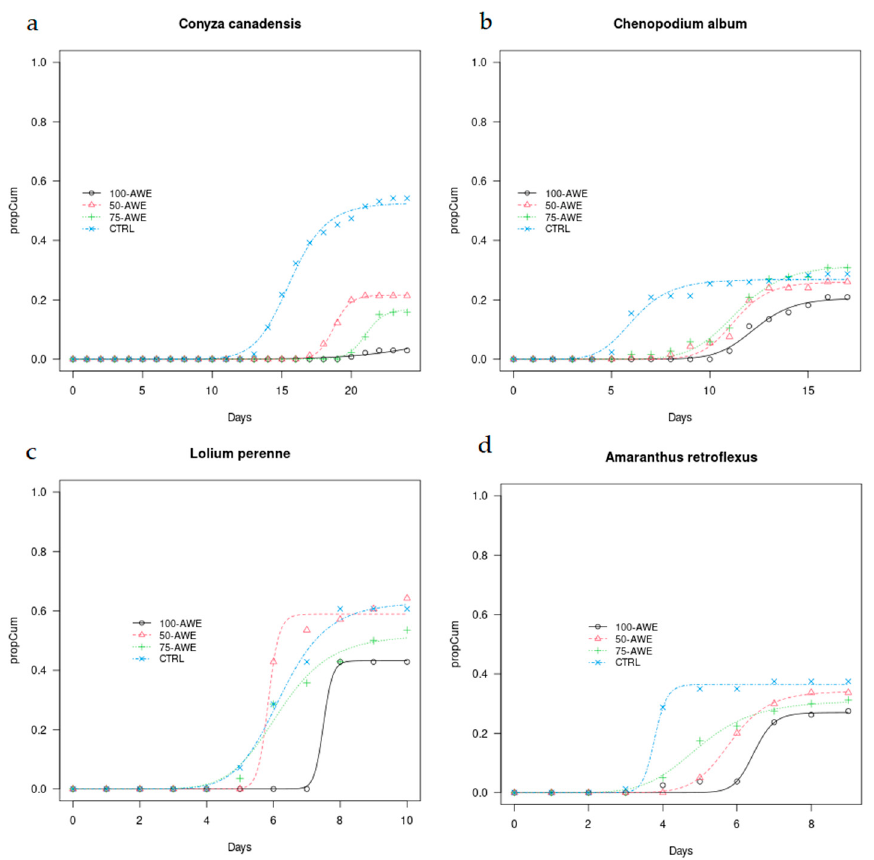
Figure 1. Time plots of cumulative germination curves calculated until the end of the monitoring for ( a ) Conyza canadensis L., ( b ) Chenopodium album L., ( c ) Lolium perenne L., ( d ) Amaranthus retroflexus L. under AWE treatments (50% AWE, 75% AWE, 100% AWE) and control